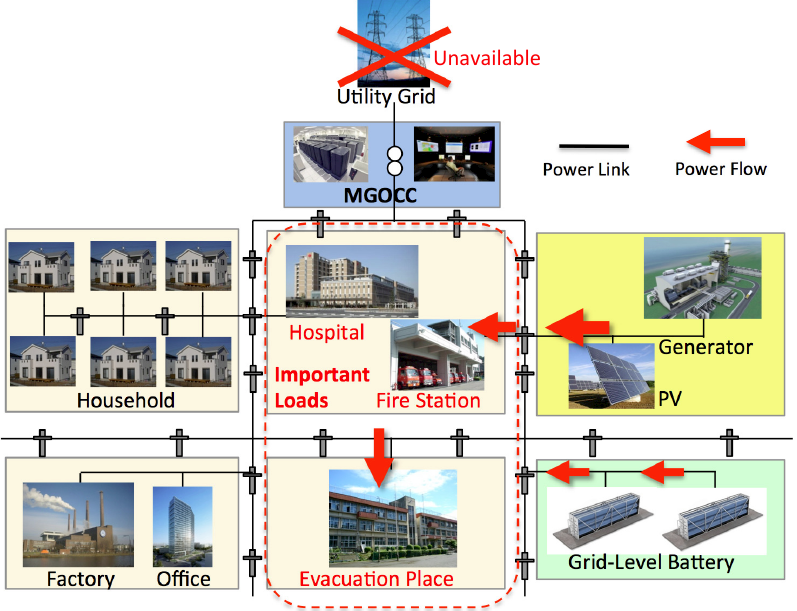
Figure 2. Overview of the proposed load shedding considering the priority of loads.